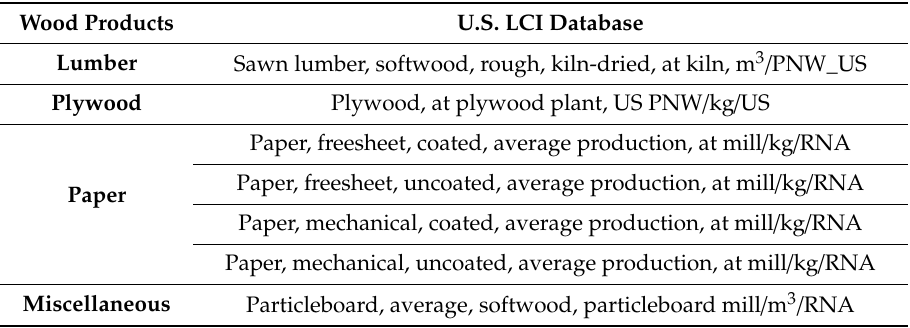
Table 1. US Life Cycle Inventory (LCI) databases used for the wood products greenhouse gas (CO 2 and CH 4 ) emission